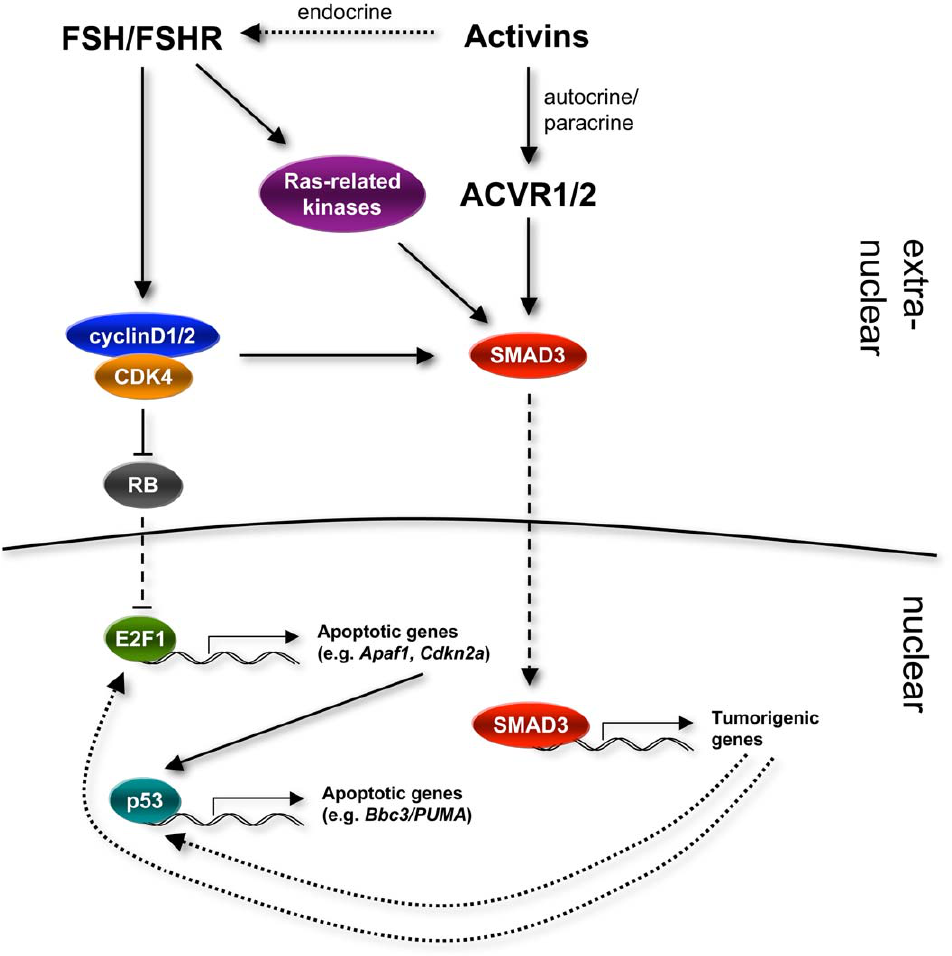
Figure 6. Proposed mechanism of Sertoli cell tumorigenesis in Inha 2 / 2 mice and acceleration of dysfunction in Inha/Rb dKO mice. Activins signal through type 1 and 2 activin receptors (ACVR1/2) to phosphorylate and activate SMAD3. Deletion of inhibin a not only leads to loss of competitive inhibition at the level of ACVR1/2 receptors, but it also leads to a pathological increase in activin levels. In our model, excess activin and FSH signaling synergistically activate SMAD3 tumorigenic pathways. Although the current studies suggest RB is not an important modifier of the inhibin a KO phenotype, we speculate that FSH mediates crosstalk between the RB pathway and inhibin a KO tumorigenic pathway by activating cyclin D1/2, which also modulates SMAD3 activity to affect tumor development and progression. We propose that SMAD3 activation synergizes with loss of RB in Inha/Rb dKO Sertoli cells thus resulting in the upregulation of E2F1- and p53-target genes. Solid line, direct interaction; dotted line, indirect interaction; dashed line, nuclear translocation.